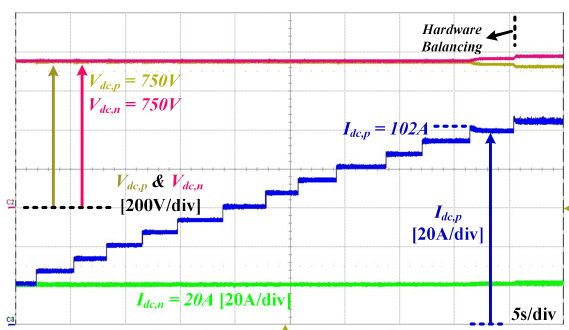
Figure 15. Experimental results of the balanced DC-link voltage using zero-sequence voltage and limitation: 102 A i dc , p and 20 A i dc , n .